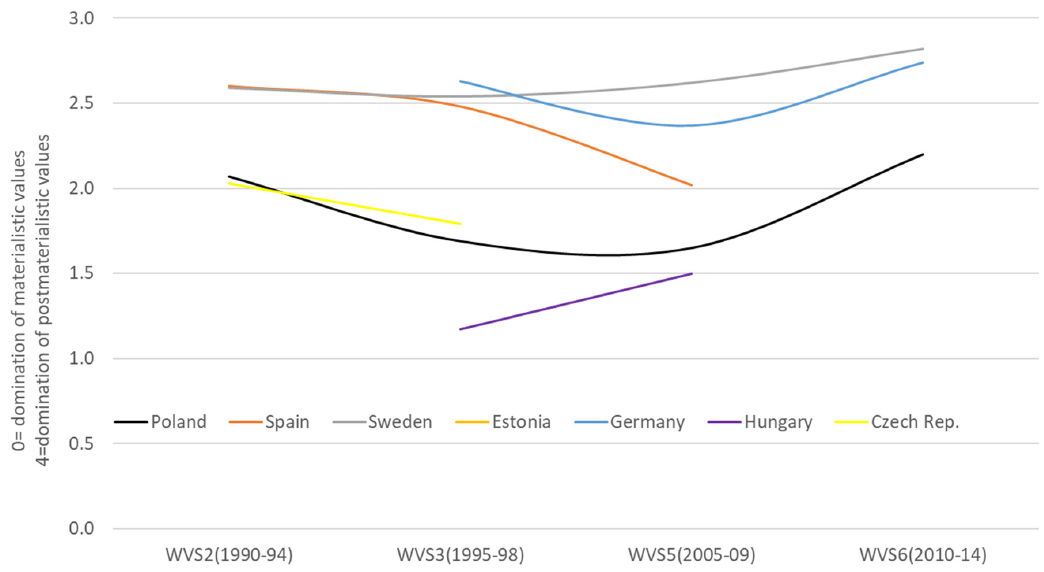
Figure 15. The development of the post-materialist index. Source of data: WVS, Waves 2–6.